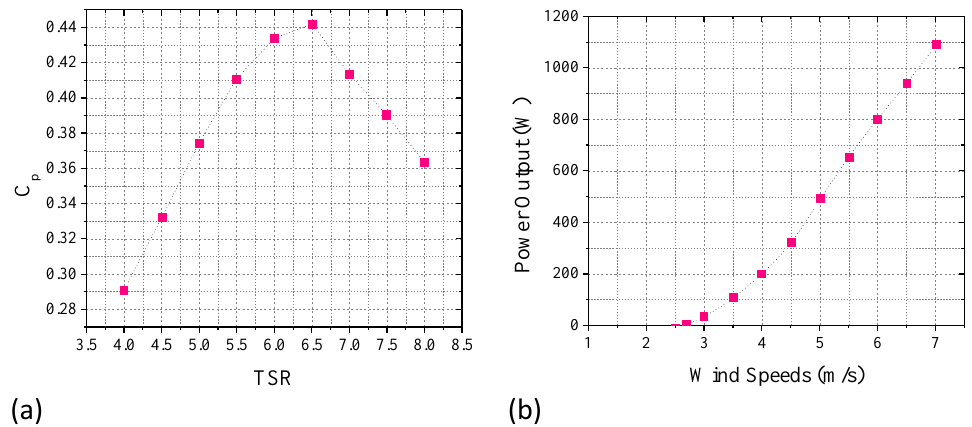
Figure 21. ( a ) Power coefficient; ( b ) output power Muhsen, et al. [14].